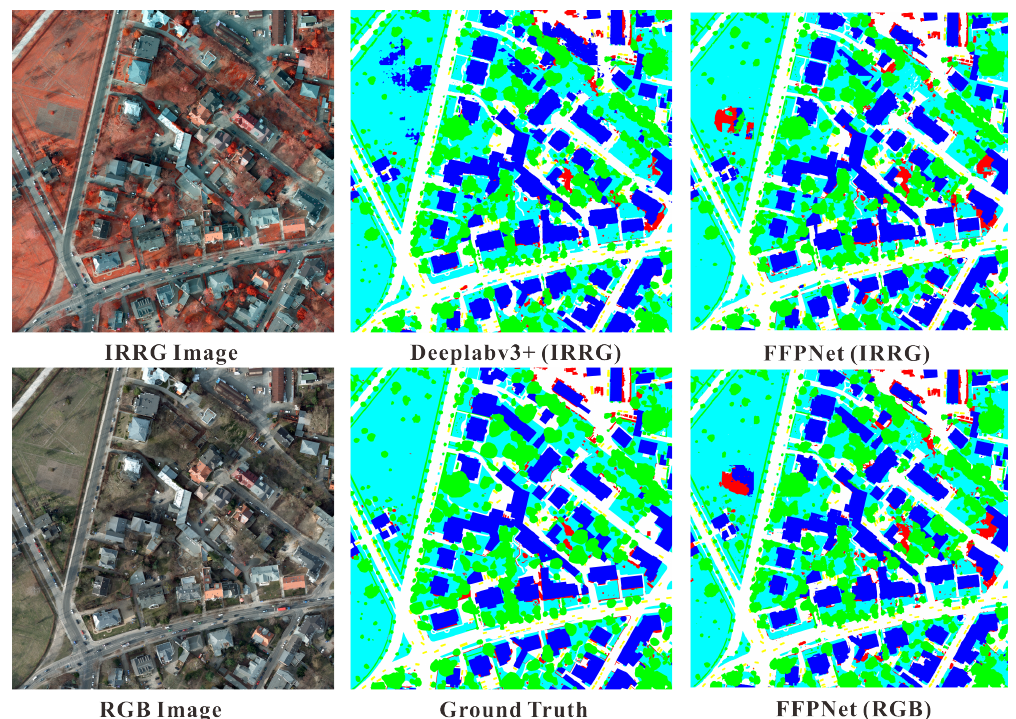
Figure 10. Qualitative comparisons of the two types of available input images (IRRG and RGB) on the Potsdam test